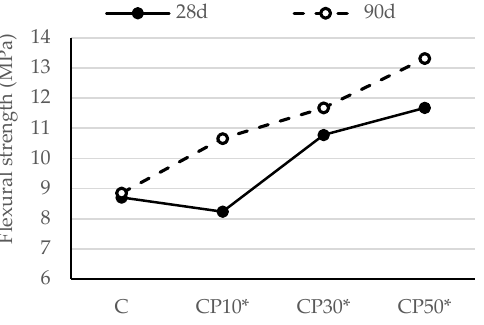
Figure 13. Flexural strength of mortars blended with ceramic powder, with decreased w/b.